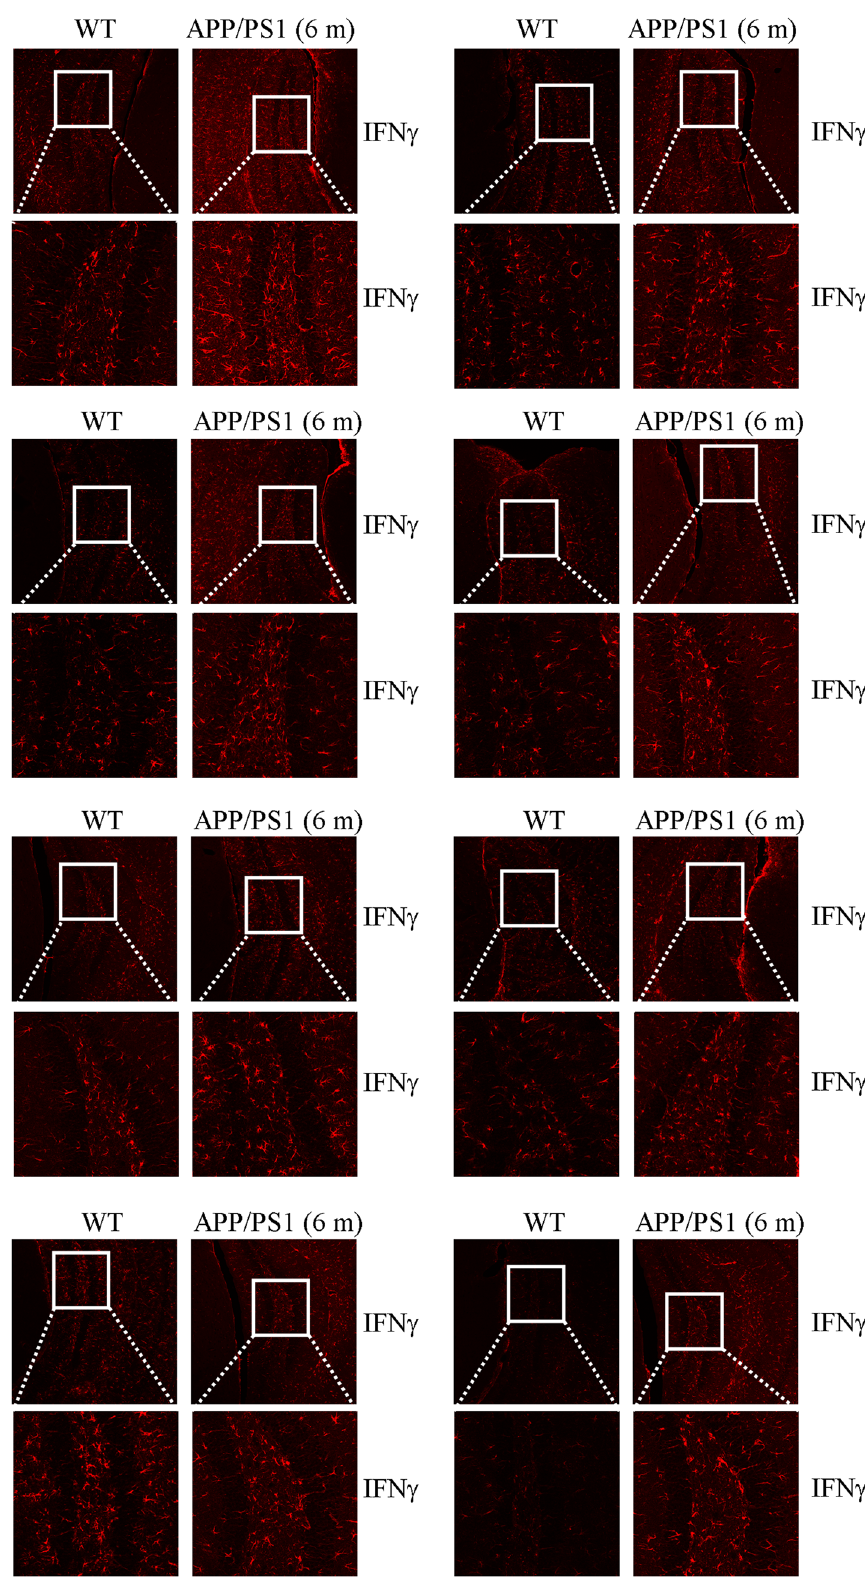
Figure 1. Additional replicates for the experiment depicted in Figure 1B in the